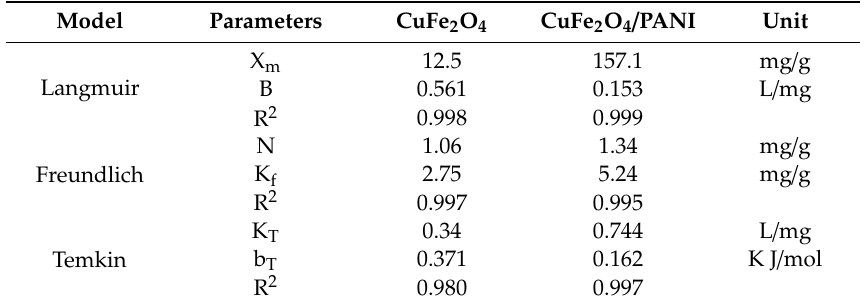
Table 3. Isotherm constants for the adsorption of mercury onto CuFe 2 O 4 and CuFe 2 O 4 / PANI nano-composites.